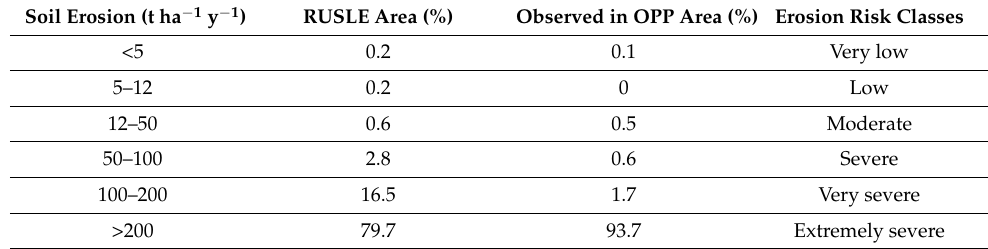
Table 4. Soil loss prediction obtained by the RUSLE model observed soil loss and erosion risk classes adapted from [38] in the